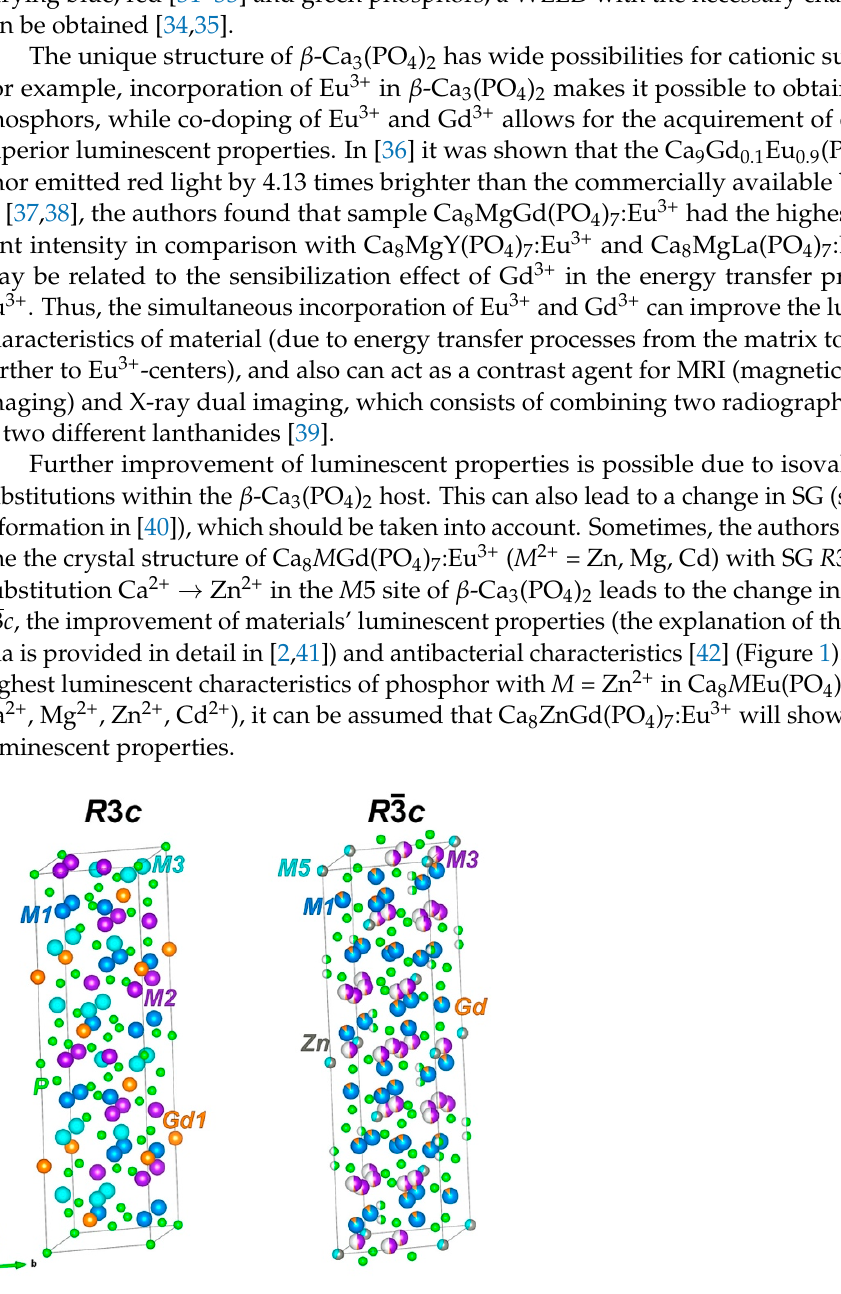
Figure 1. β -Ca 3 (PO 4 ) 2 -type structure with R 3 c (Ca 9 Gd(PO 4 ) 7 ) and R 3 c (Ca 8 ZnGd(PO 4 ) 7 ) space groups. Half of the spheres show occupancy of 0.5 (for example, in M 3 site).